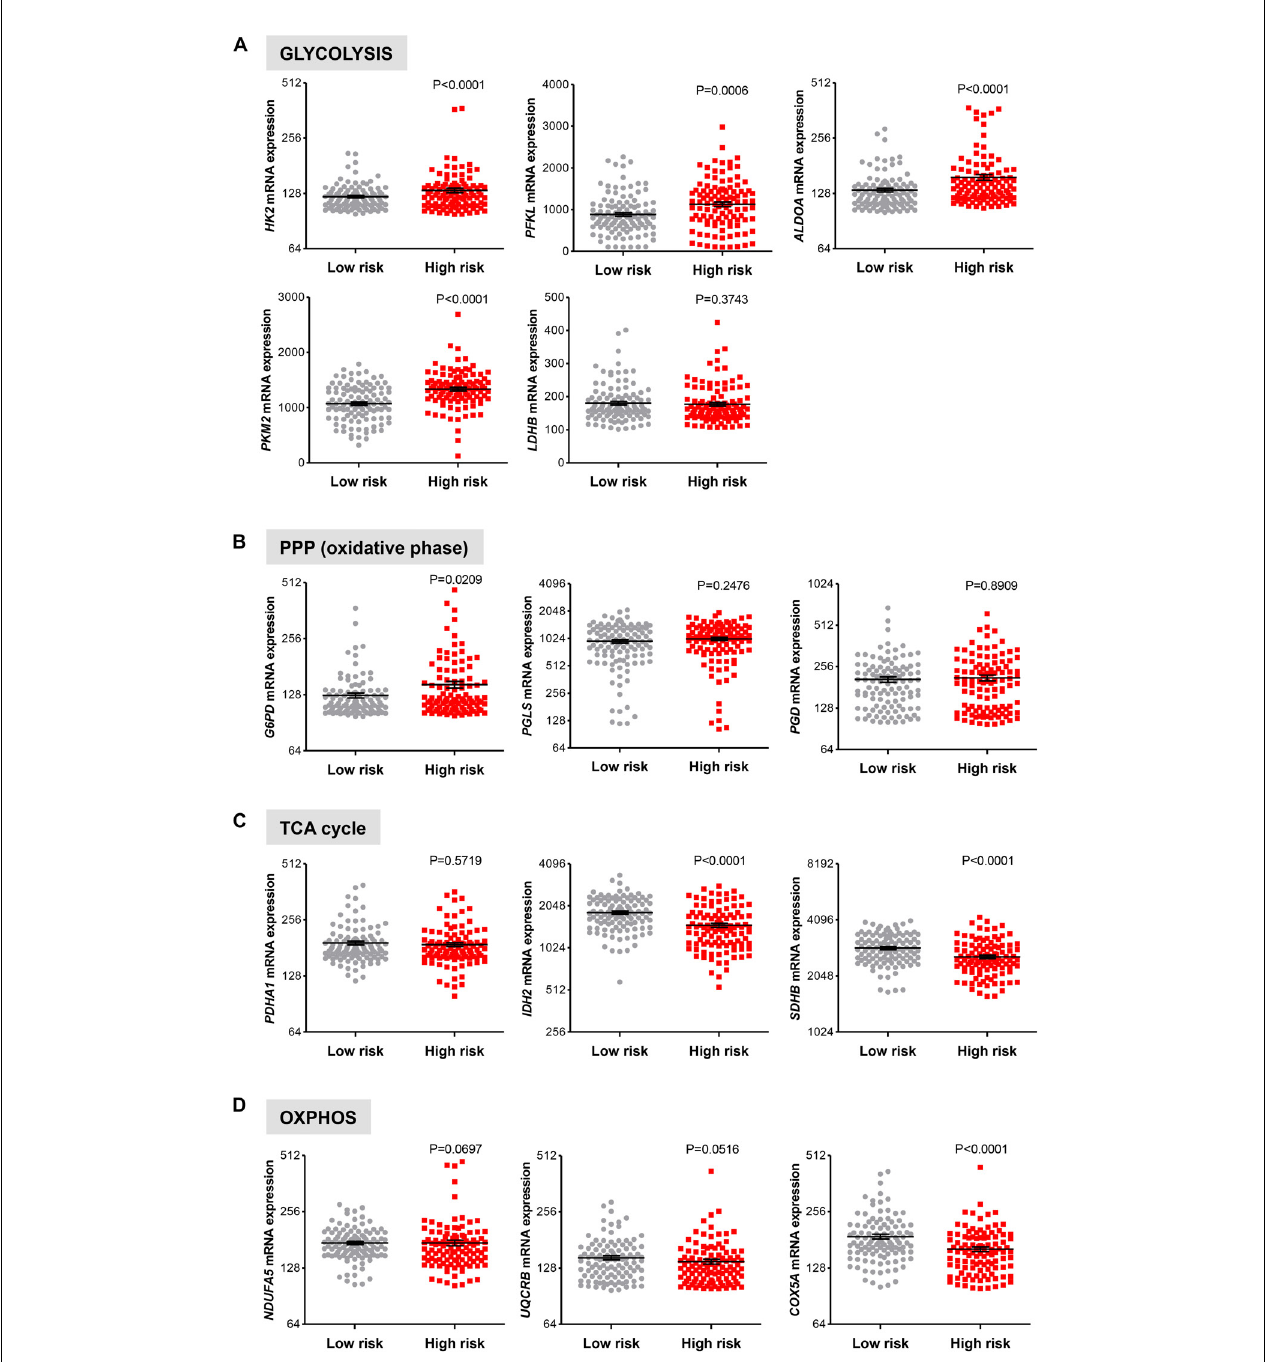
FIGURE 7 | Increased risk of developing HCC in cirrhotic patients significantly correlates with high expression of glycolytic genes. (A–D) Levels of transcripts in the clinical data set GSE15654 consisting of 115 patients with newly diagnosed cirrhosis who were prospectively followed up in an HCC surveillance program and classified as having low ( n = 55) and high ( n = 60) HCC risk based on the rates of patient survival and risk of developing HCC (Hoshida et al., 2013). The horizontal lines indicate mean ± SEM P -values were calculated by non-parametric Mann–Whitney tests.